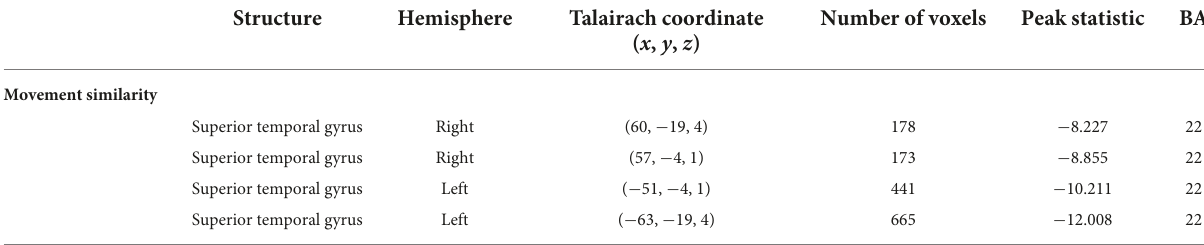
FIGURE6 Activation for the median values of movement similarity. Regions of activity are in the left and right superior temporal gyrus. Note that clusters found for movement similarity are negatively correlated.